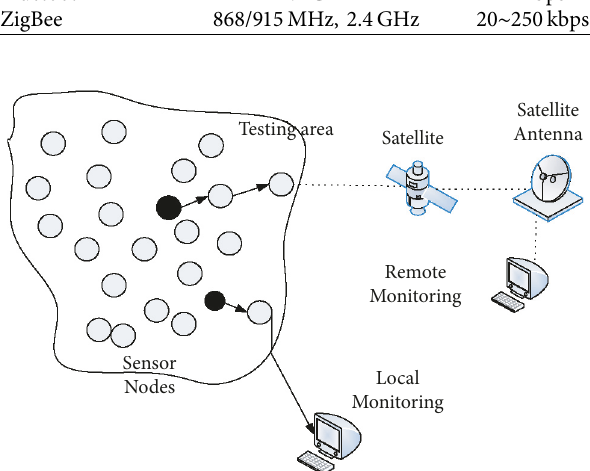
Figure 1: Architecture of a sensor